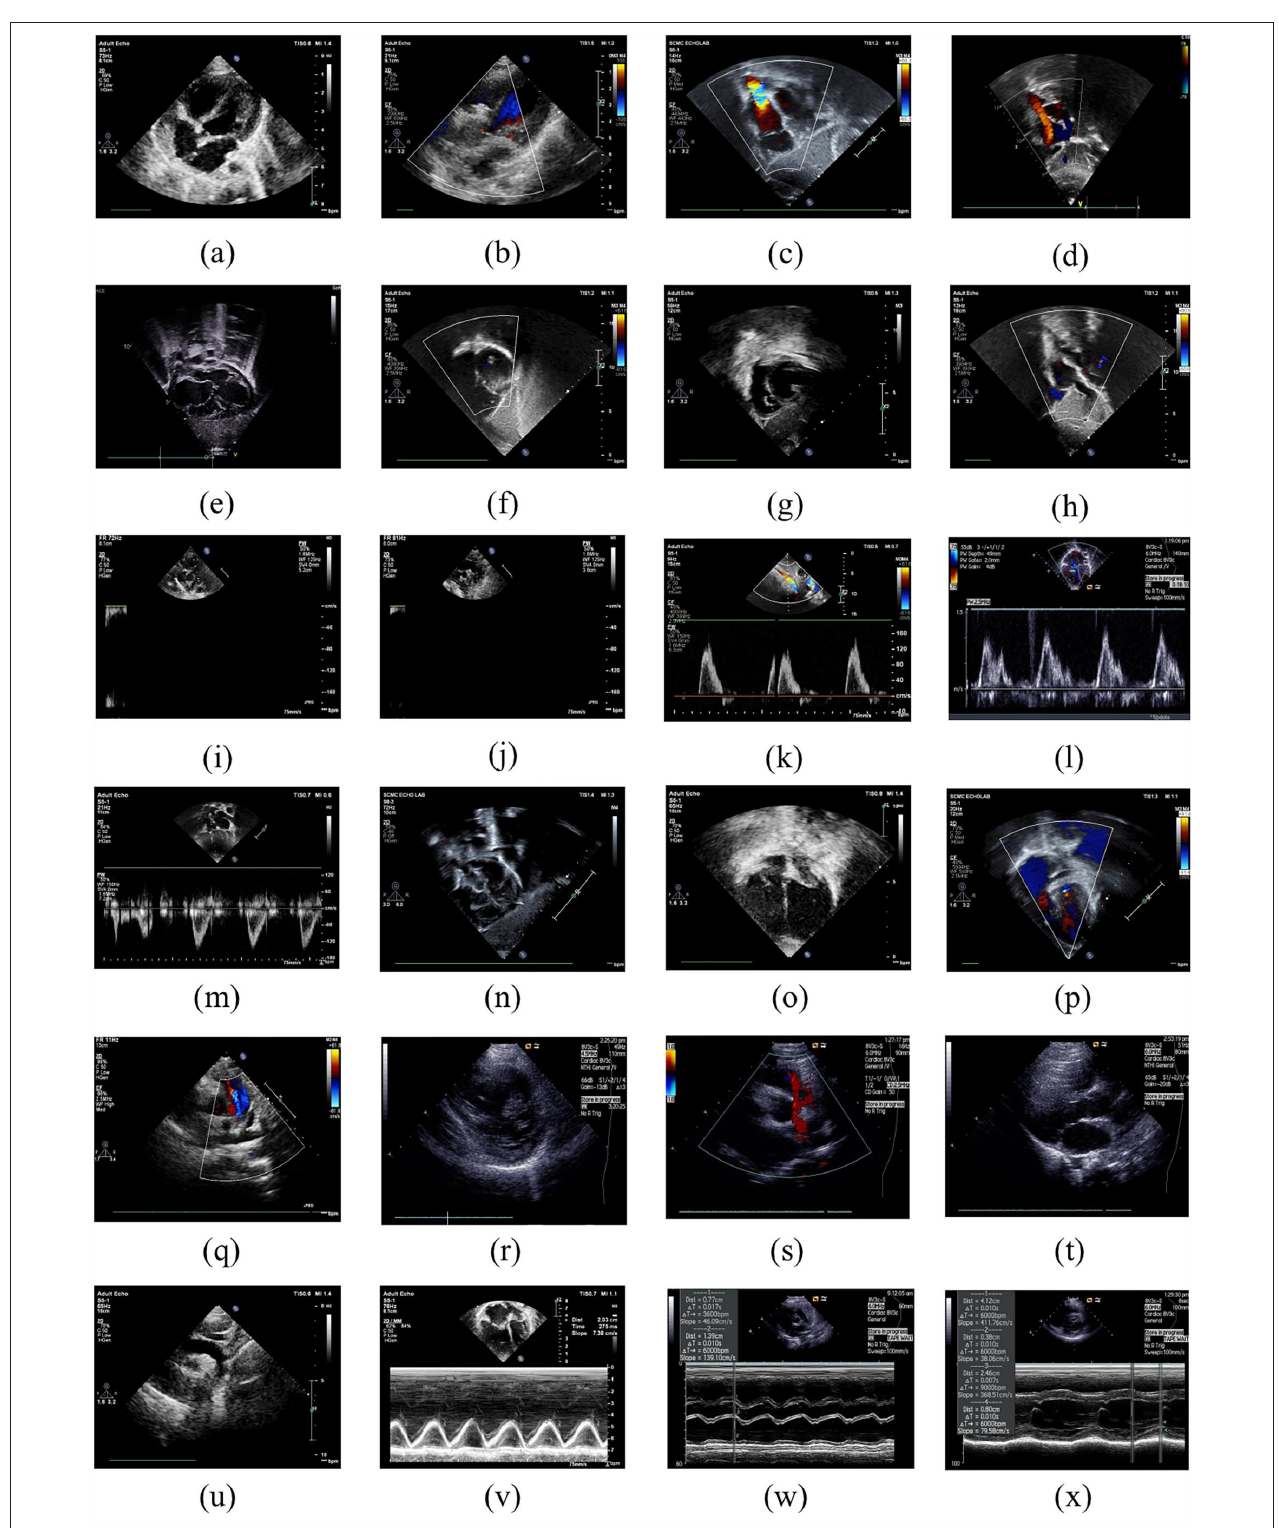
FIGURE 1 | Example images of the 24 standard echocardiographic views: (a) LPS4C; (b) LPS5C; (c) subCAS; (d) subSAS; (e) sub4C; (f) subRVOT; (g) subSALV; (h) DP-MV; (i) DP-PV; (j) DP-DAO; (k) DP-OTHER; (l) DP-TV; (m) DP-AAO; (n) OTHER; (o) A4C; (p) A5C; (q) sax-basal; (r) sax-mid; (s) PSLA; (t) PSPA; (u) supAO; (v) M-OTHER; (w) M-AO; (x)